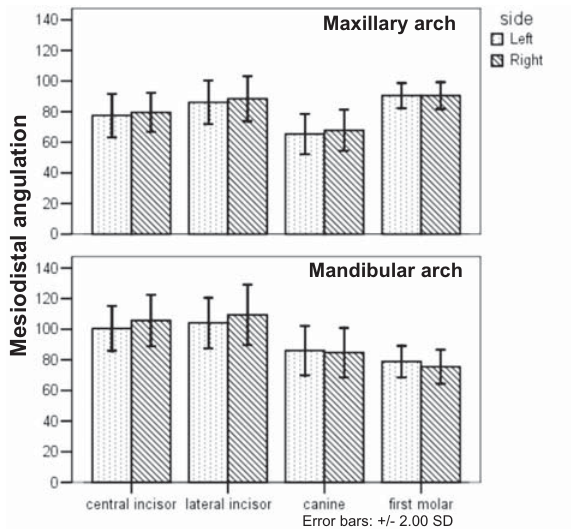
Figure 2- Mesiodistal angulation of differents homologous teeth in children with mixed dentition. SD= standard